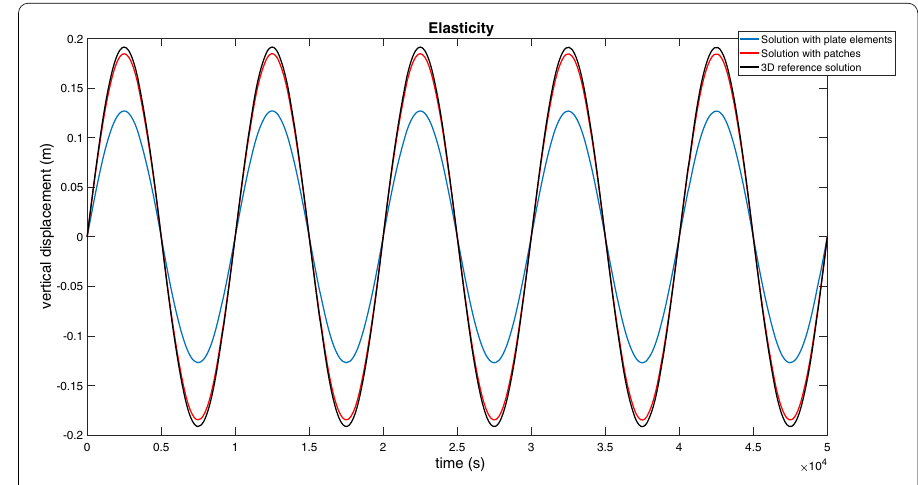
Fig. 19 Vertical elastic displacement evolution in time at the right